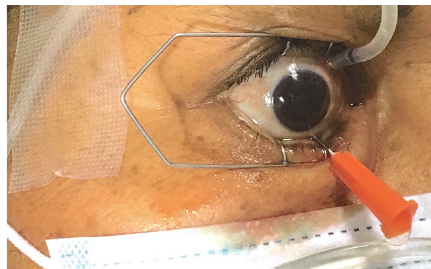
Figure 1: Photograph showing the infusion cannula placed superi- orly3mmfromthesclerocorneallimbusatthe2o’clockpositionand the hemorrhagic fluid egressing the eye through the 25 Ga needle placed inferiorly.